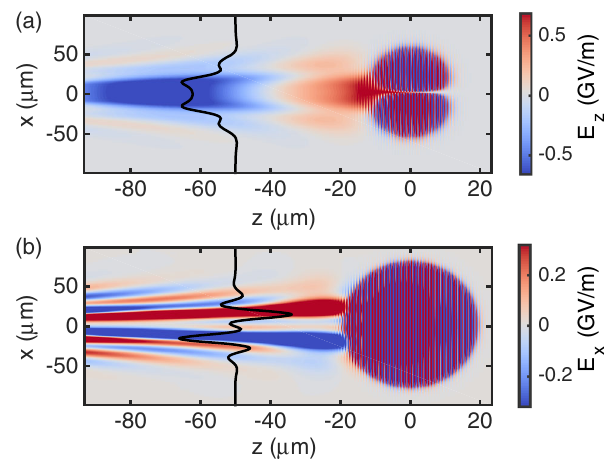
FIG. 5. Wakefield in a low-density guiding channel ( n ¼ 1 × 10 15 cm − 3 ). (a) and (b) show the longitudinal and transverse electric field, respectively. The lineouts of the fields 50 μ m behind the laser show a dip in E on axis and a change of z sign in E , which is defocusing to x